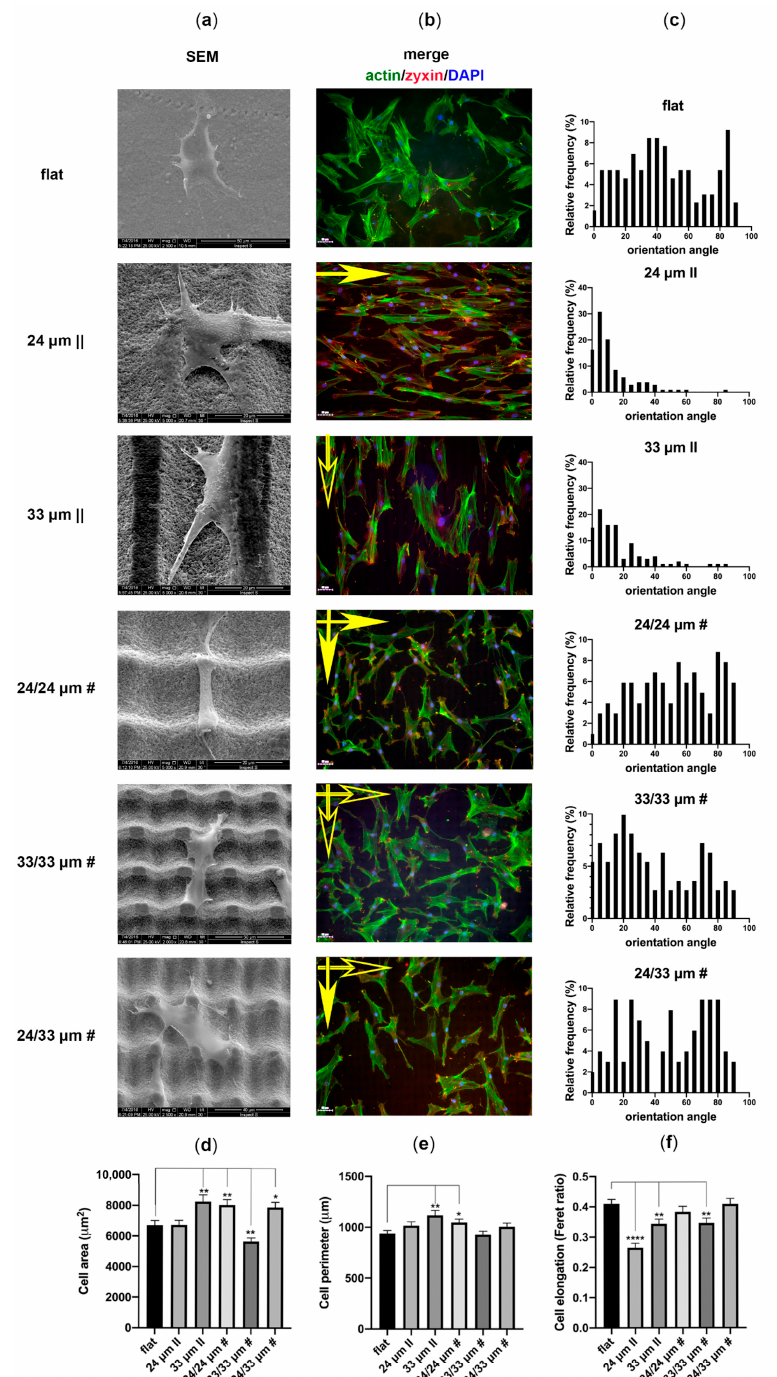
Figure 5. Adhesion of human mesenchymal stromal / stem cells hMSCs onto Zirconia microtopographies. A. Scanning electron microscopy (SEM) ( a ) and immunofluorescence microscopy ( b ) images, and their corresponding quantifications ( c – f ) at 3 days post-seeding onto the tested biomaterials. High-magnification SEM images ( a ) are presenting individual cell interactions with each of the structured Zirconia substratum. The fluorescence images ( b ) were obtained upon labeling with antibodies for zyxin (red), staining of actin filaments with Alexa Fluor 488-Phalloidin (green), and nuclei with Hoechst (blue). Arrows indicate the direction of irradiated line structures (full arrow for 24 µ m step; empty arrow for 33 µ m step). Percentage of cells for each orientation angle versus the horizontal direction are shown in frequency distribution histograms ( c ). Quantitative measurements of cell areas ( d ), perimeters ( e ) and elongation ( f ) are shown in graphs. Image acquisition was performed using the TissueFAXS iPlus automatic system. Data represent mean ± S.E.M., * p < 0.05, ** p < 0.01, **** p <